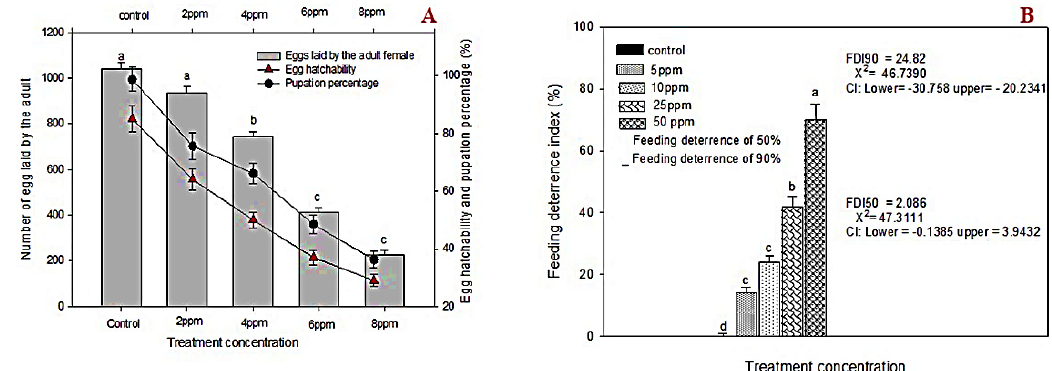
Figure 3. ( A ) Mean percent fecundity, egg hatch and pupation of S. litura after fed on leaves treated with fraction VII from Desmostachya bipinnata . Means (± (SE) standard error) followed by the same letters above bars indicate no significant difference ( p ≤ 0.05) according to Tukey’s test. ( B ) Antifeedant activity of S. litura after treated with fraction VII from D. bipinnata . Means (±(SE) standard error) followed by the same letters above bars indicate no significant difference ( p ≤ 0.05) according to Tukey’s test.